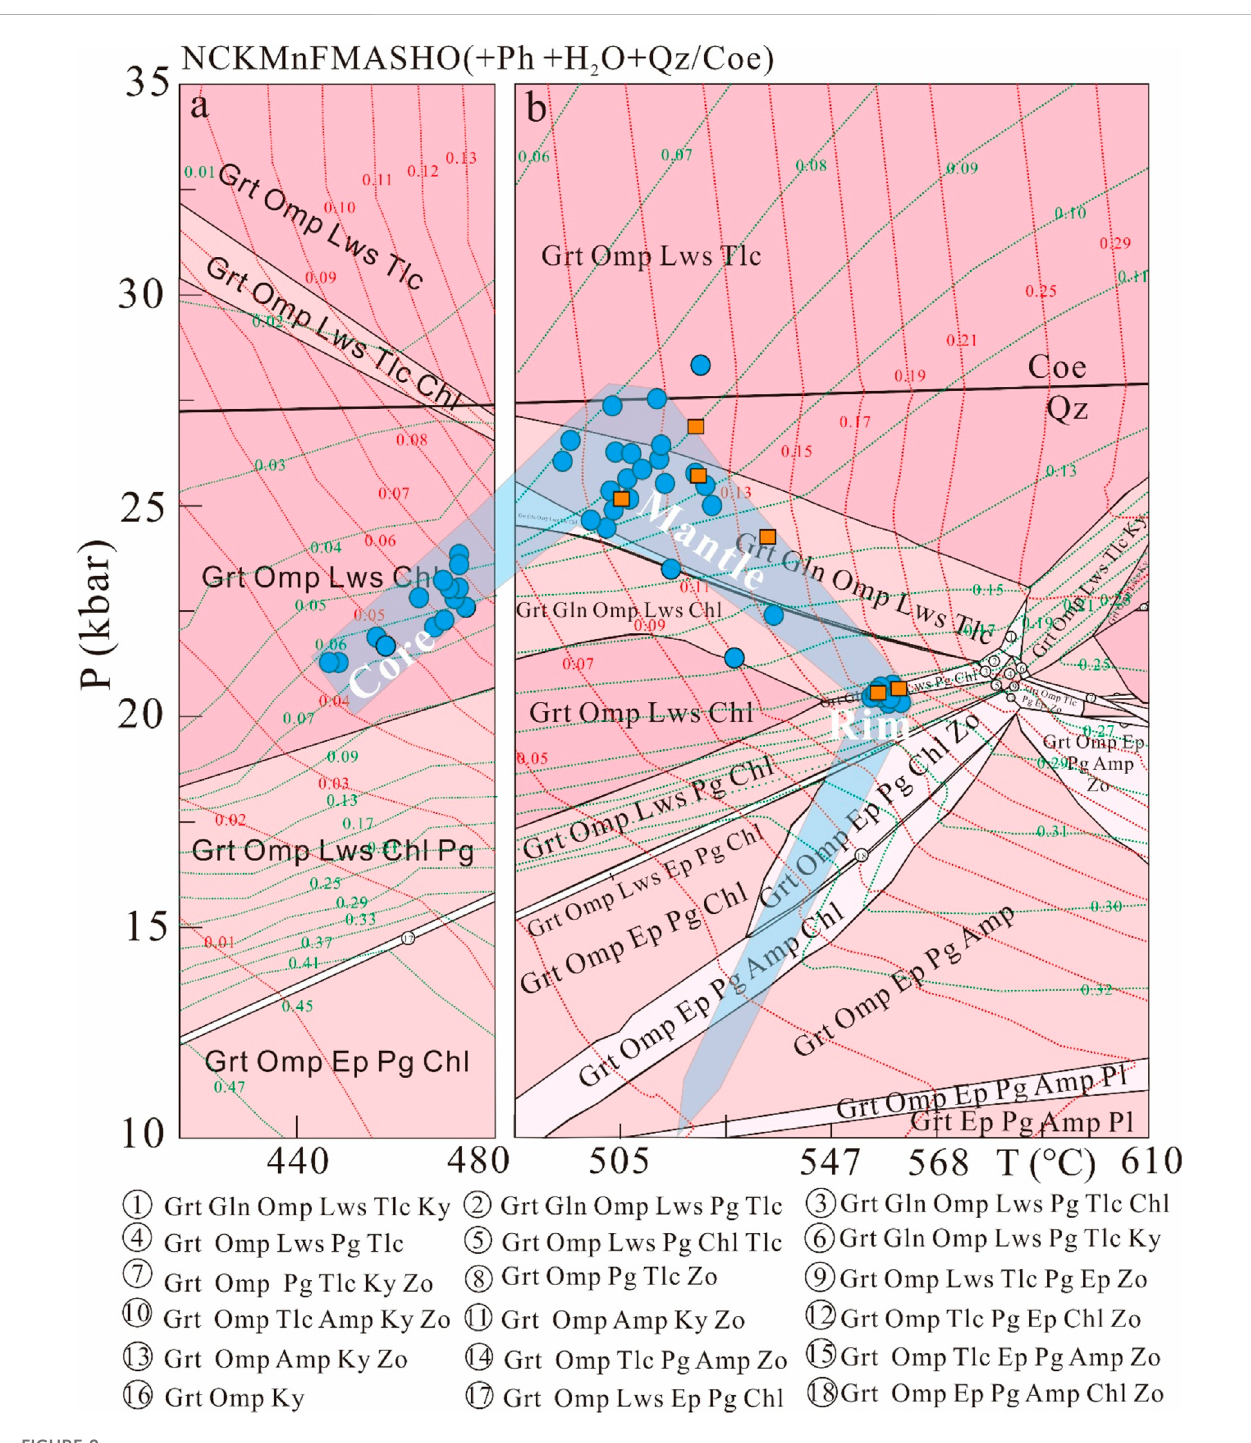
P-T pseudosection calculated for the coesite pseudomorph-bearing felsic schist HB121-2 in the NCKMnFMASHO system (+ Ph + H 2 O+ Qz/Coe) calculated by the bulk rock composition (A) and effective bulk composition (B) . The contours are the isopleths of X gr (green dotted line) and X py (red dotted line) in garnet. Garnet compositions of Grt E (blue circles) and Grt Q (orange squares) are